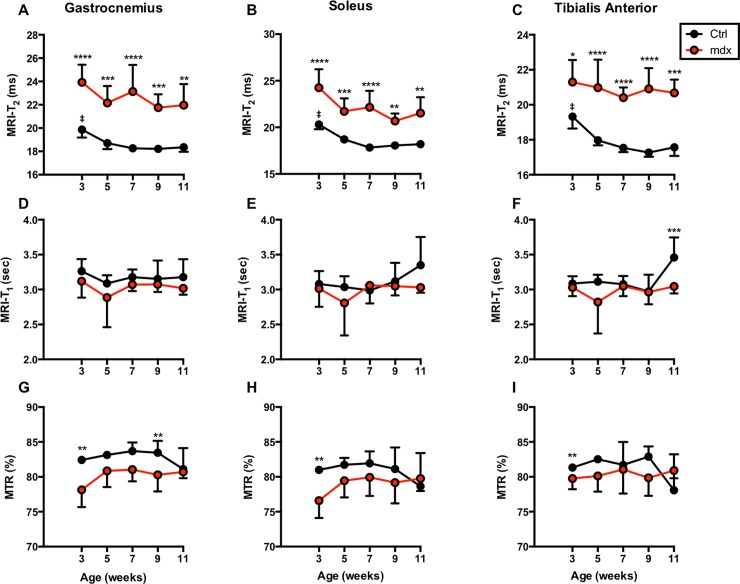
T2, T1, and MTR values analyzed for TA, GA, and SOL muscles.Graphs displaying the average longitudinal values of the mdx4cv and control mice muscles in the T2, T1, and MTR measures. T2 values for the mdx4cv mice were significantly higher at all time points versus age-matched controls. *p ≤ 0.05, **p ≤ 0.01, ***p ≤ 0.001, and ****p ≤ 0.0001. Significant higher T2 values were detected in ctrl mice at 3 weeks of age compared to other time-points. ‡p ≤ 0.05.